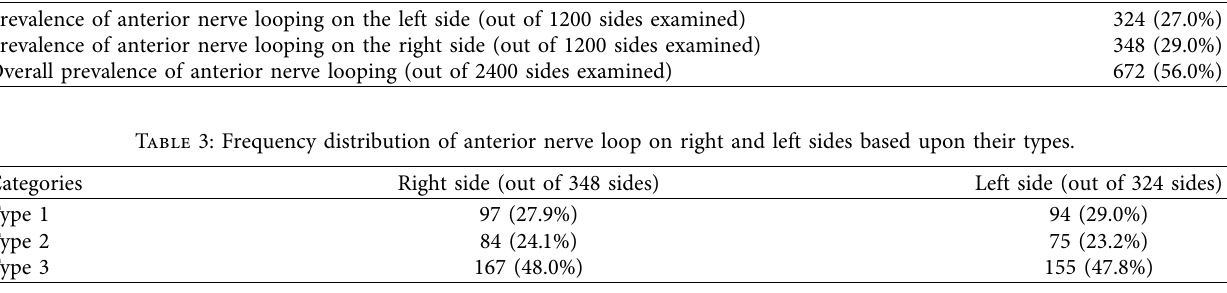
Table 4: Distribution of study population according to the prevalence of anterior looping of alveolar nerve on right and left sides. Factor